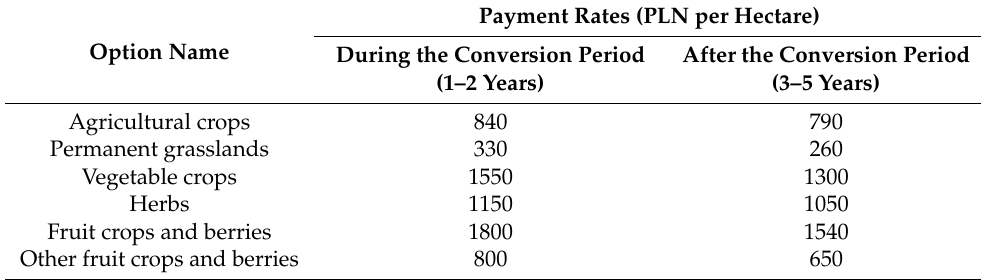
Figure 2. Payment amounts by organic farming option under the 2004–2006 RDP. Source: own compilation based on [64]. Table 3. Organic payment rates under the 2007–2013